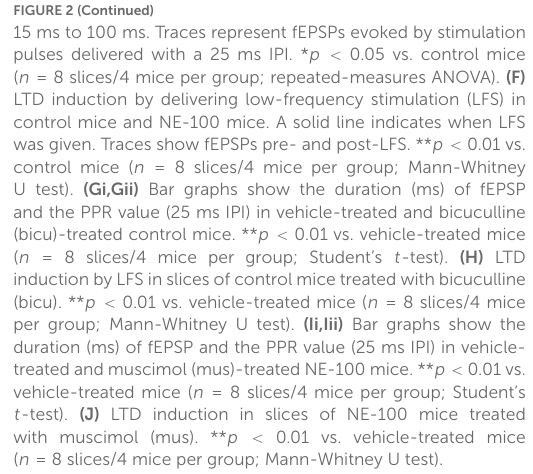
Figure 4E ; β 3: F (2,42) = 3.502, p = 0.041; Figure 4F ), but not